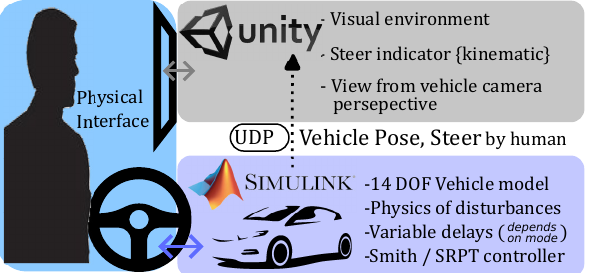
Figure 1. Integration of Simulink and Unity for human-in-loop vehicle teleoperation experiments.